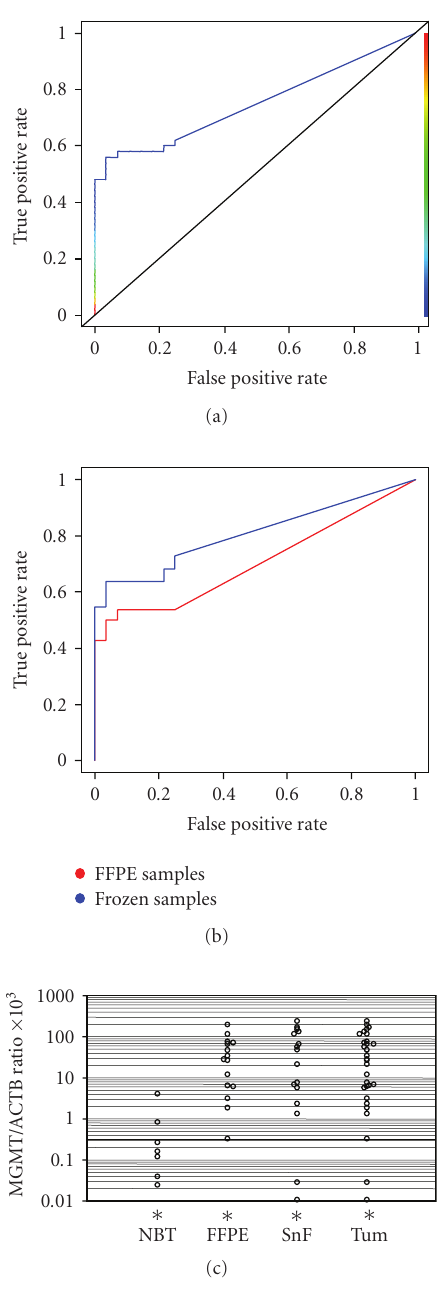
Figure 2: ROC curve analysis of Quantitative Methylation-specific PCR results . (a) ROC curve for QMSP assay was designed on the basis of MGMT / ACTB ratios in determined in normal brain tissues ( n = 28) and total tumour samples ( n = 50). The area under the curve (AUC) is 0.74 ( P = . 000001). (b) Comparison of ROC curves were designed on the basis of MGMT / ACTB ratios determined in normal brain tissues ( n = 28) and FFPE ( n = 28) or snap- frozen specimens ( n = 22). The area under the curve (AUC) is 0.70 ( P = . 001) for FFPE samples and 0.79 ( P = . 0000001) for snap-frozen specimens. (c) Scatter plot in logarithm scale of MGMT / ACTB ratios in normal brain tissue (NBT), tumour FFPE samples, and snap-frozen (SnF) specimens. ∗ indicates samples with an MGMT / ACTB ratio of 0 which cannot be plotted on a logarithm scale ( n = 21 for NBT, n = 13 for FFPE and n = 6 for SnF). The horizontal line indicates the optimal cuto ff value of